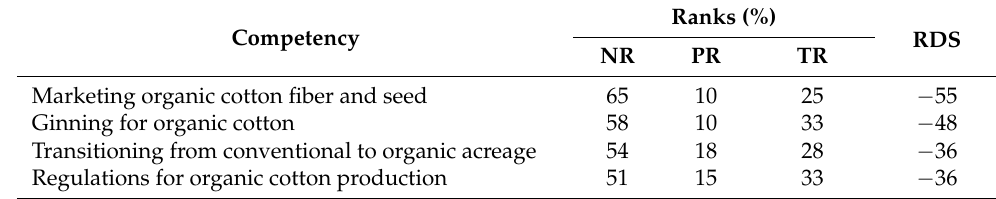
Ranks (%) RDS NR PR TR